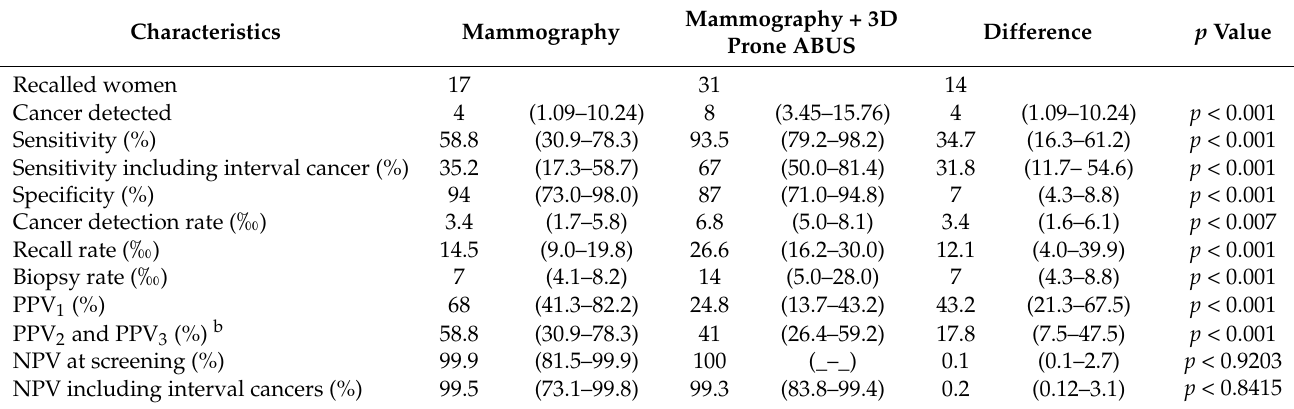
Table 3. Mammography and 3D prone ABUS screening